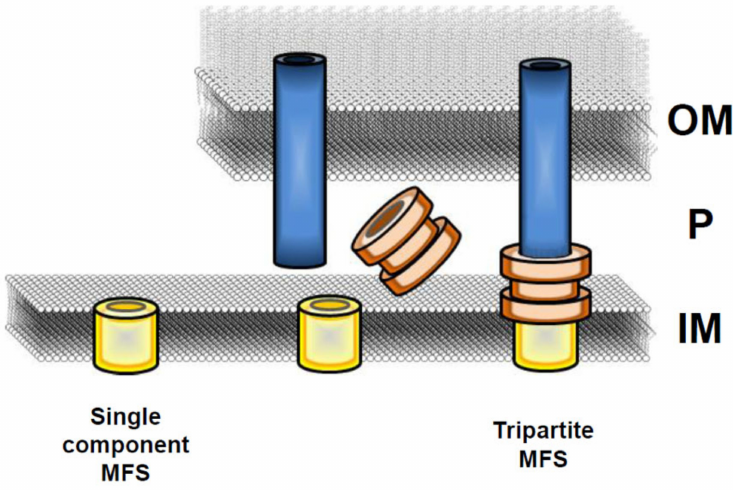
Figure 1. Schematic overview of the architecture of the e ffl ux pumps of the major facilitator superfamily (MFS) . Multidrug MFS e ffl ux pumps are typically found as single-component e ffl ux transporters in the inner membrane (IM). In Gram-negative bacteria, MFS transporters can also form tripartite complexes that directly transport substrates from the cytoplasm to the exterior. The inner membrane component does not extend into the periplasm (P) but is thought to interact with a periplasmic adaptor protein within the inner membrane. The adaptor protein forms a sealed channel between the inner and outer membrane (OM) components. The outer membrane channel is constituted usually by the TolC protein. In some cases a TolC-like protein, encoded by the same operon as the inner membrane and periplasmic components, acts as an outer membrane